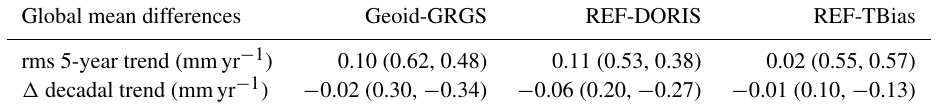
Table 6. Differences of interannual trend variability and decadal trend for merged, ascending, and descending passes related to the orbit solution. Values are derived from the mean radial orbit differences over the oceans for Geoid minus GRGS, REF minus DORIS, and REF minus TBias for the period April 1993–June 2004. Values for ascending and descending passes are given in brackets.